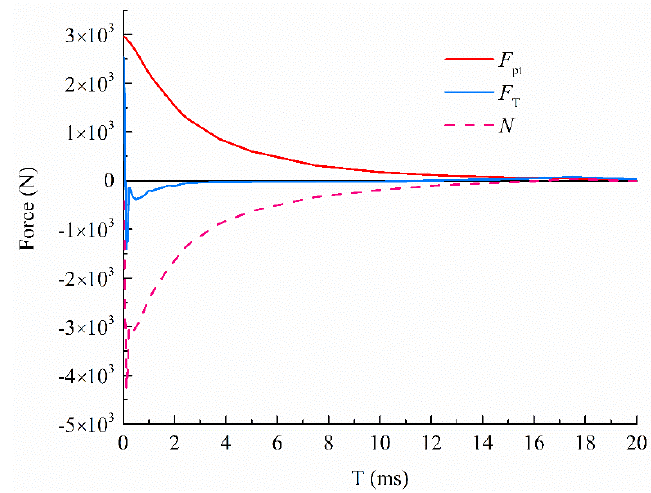
Figure 10. Force varying with time.